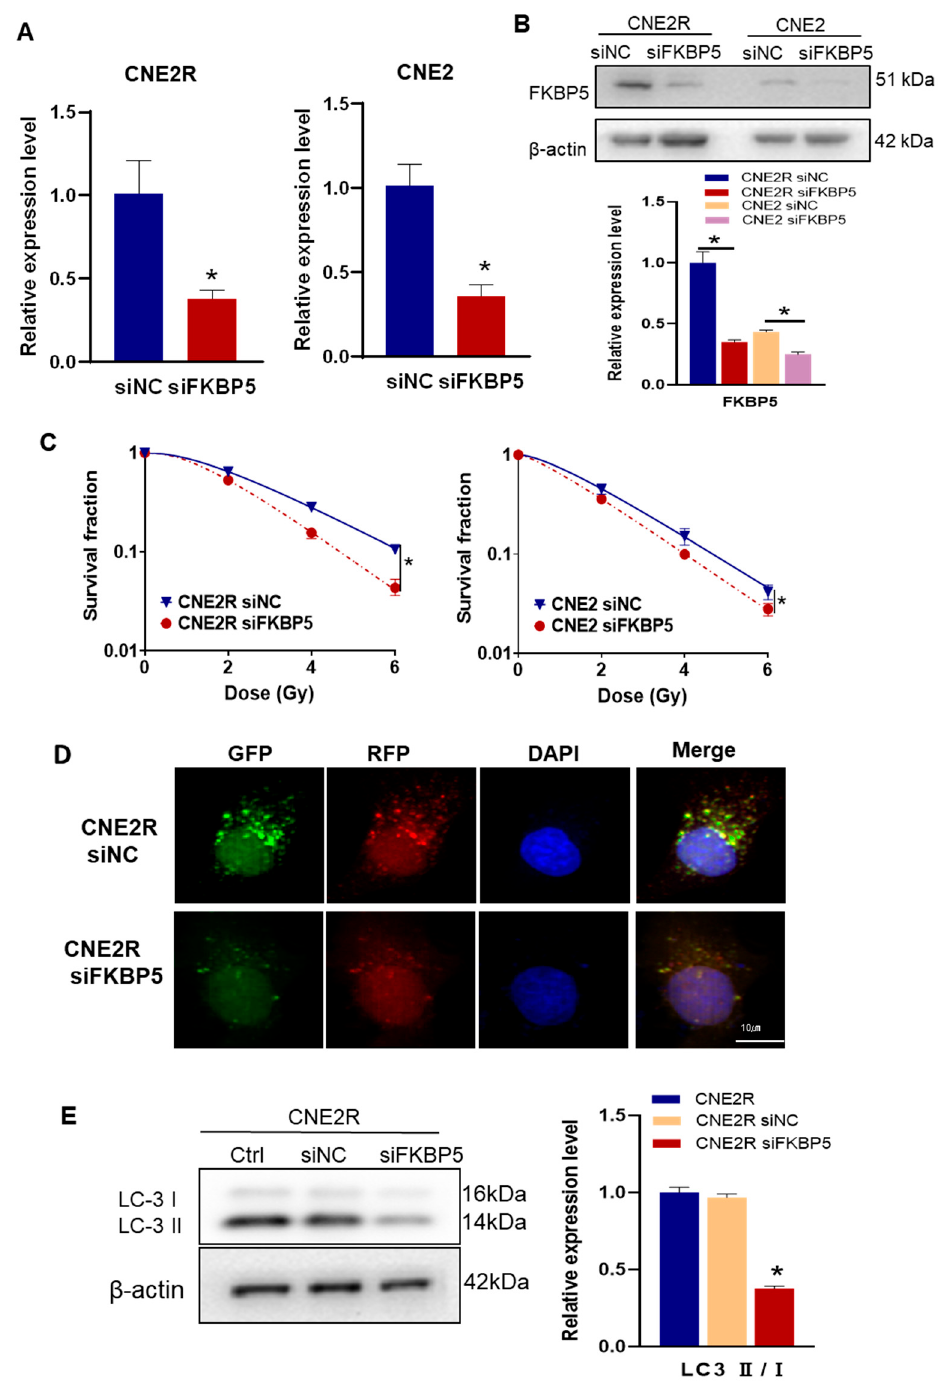
Figure 6. Knockdown FKBP5 enhanced the radiosensitivity of NPC cells by inhibiting autophagy: ( A , B ) RT-qPCR ( A ) and Western blot ( B ) assay of the expression of FKBP5 in CNE2R and CNE2 cells transfected with siFKBP5; ( C ) colony formation assay was performed to evaluate the influence of siFKBP5 on the survival fractions of CNE2R and CNE2 cells after irradiation; ( D ) fluorescence images of CNE2R cells transfected with siFKBP5 and mRFP-GFP-LC3-tagged adenovirus ( × 40); ( E ) Western blot assay of LC3 proteins in CNE2R cells after transfection with siFKBP5. * p < 0.05 compared with corresponding siNC or between indicated